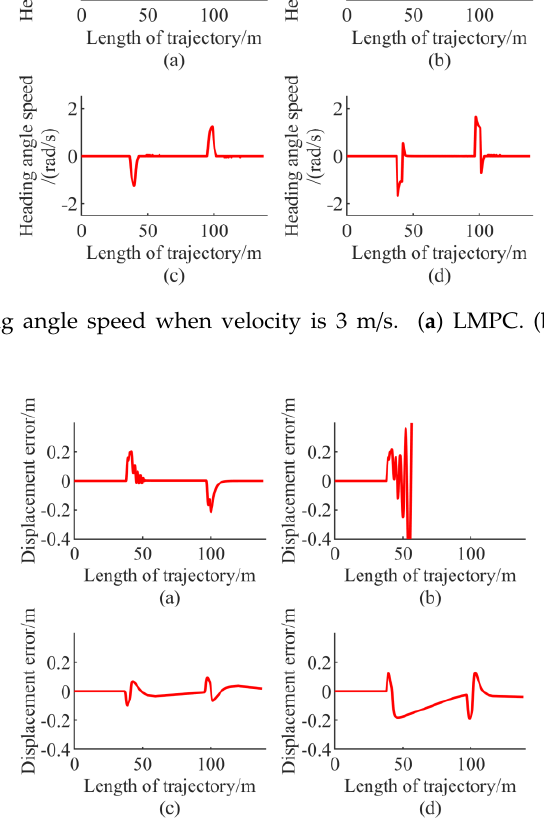
Table 3. The maximum absolute values when velocity is 3 m/s.